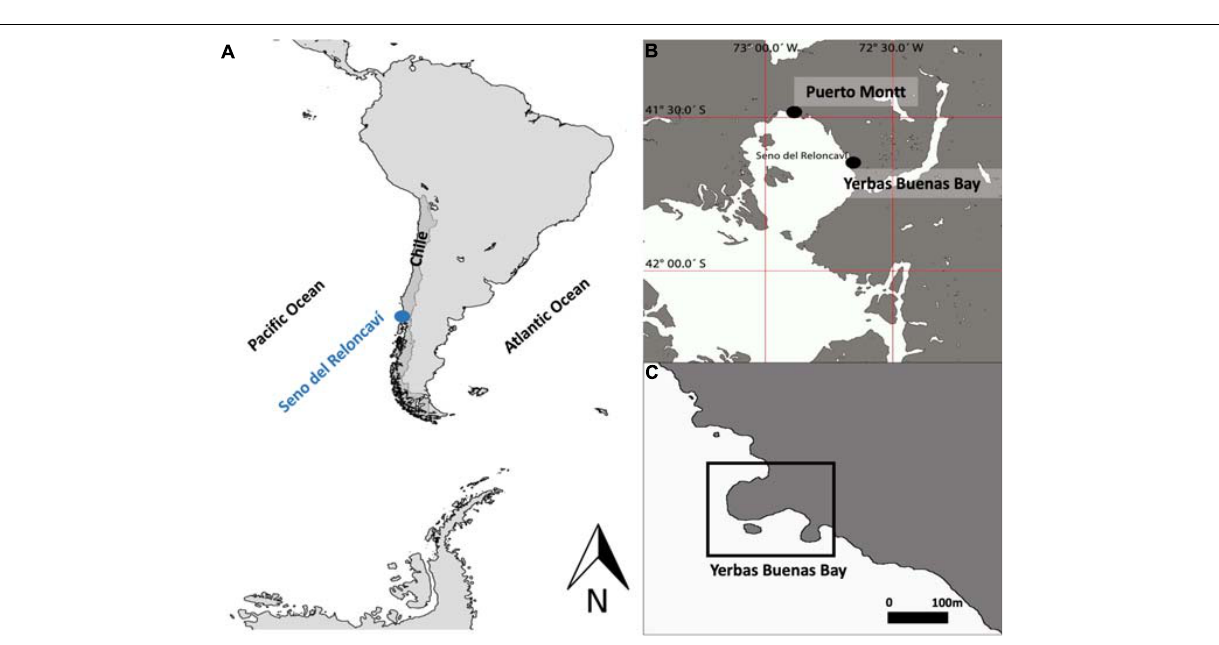
Frontiers in Marine Science |